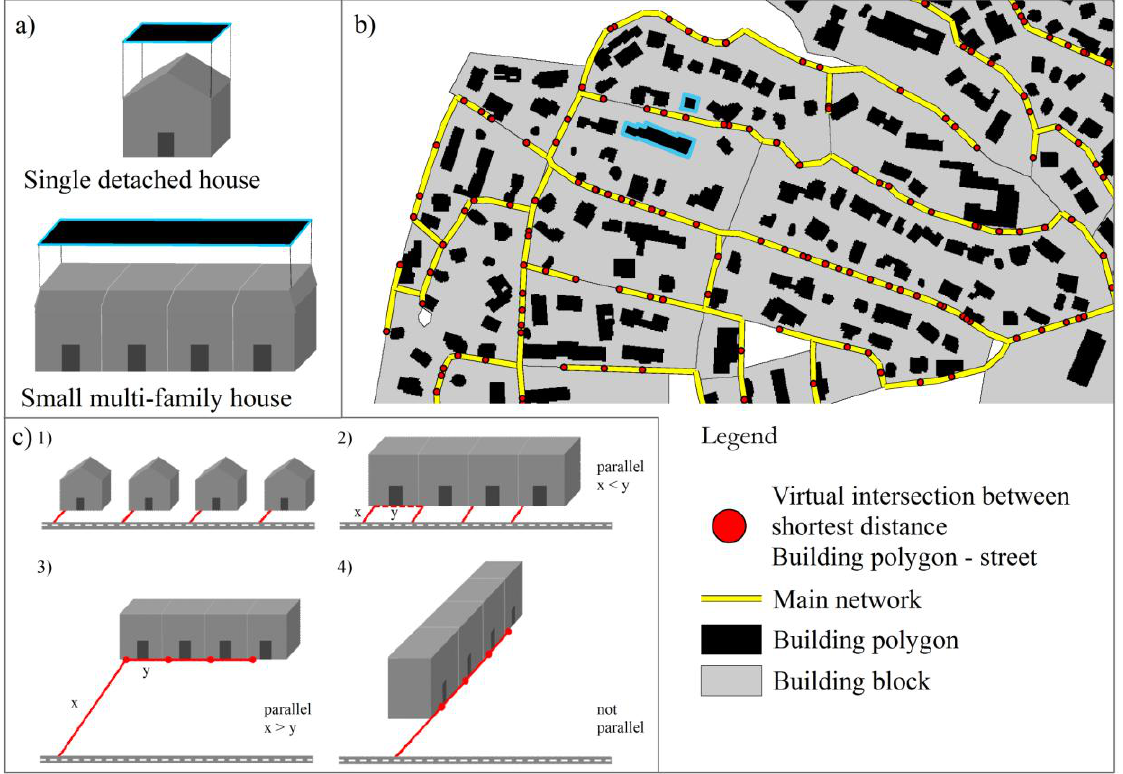
Figure 3. Calculation of infrastructural parameters. (a) Polygons of different buildings types that do not necessarily represent legal building borders; (b) Network graph generated by using a minimum spanning tree; (c) Calculation rules for several building types and location/orientation